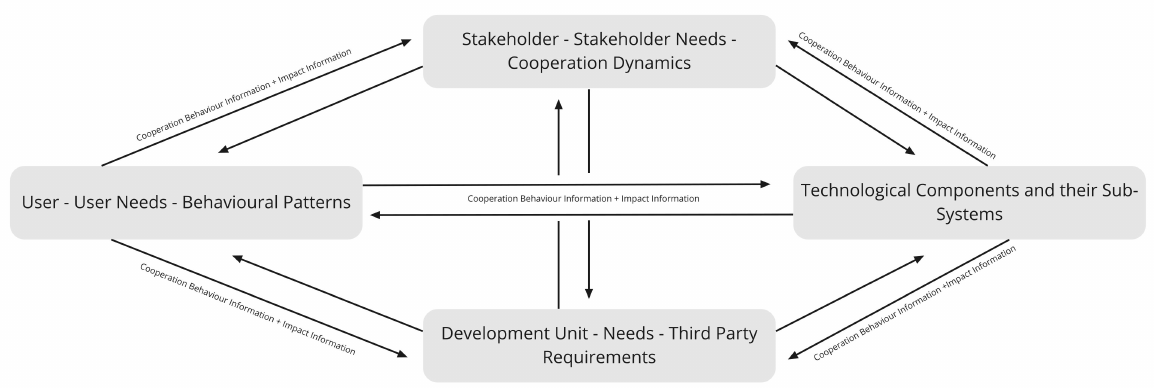
Figure 2. Anticipation Next Conceptual Mapping, authors’